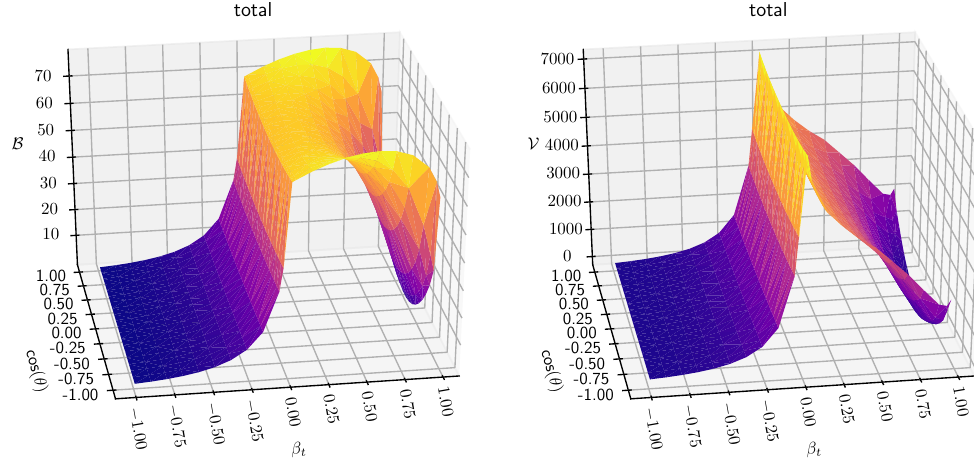
Figure 4 . Dependence of the leading order (left) and virtual contribution (right) on the parameters β t and cos θ , summing over all